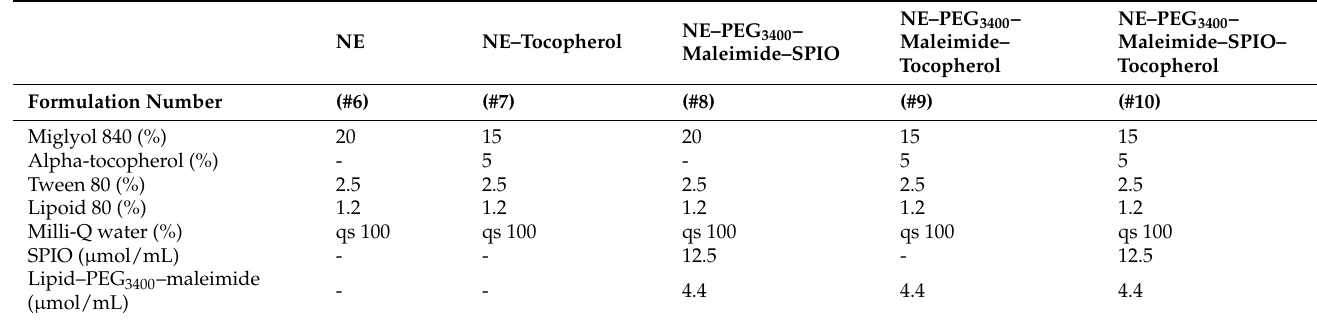
Table 3. NE composition for the antioxidant assessment.